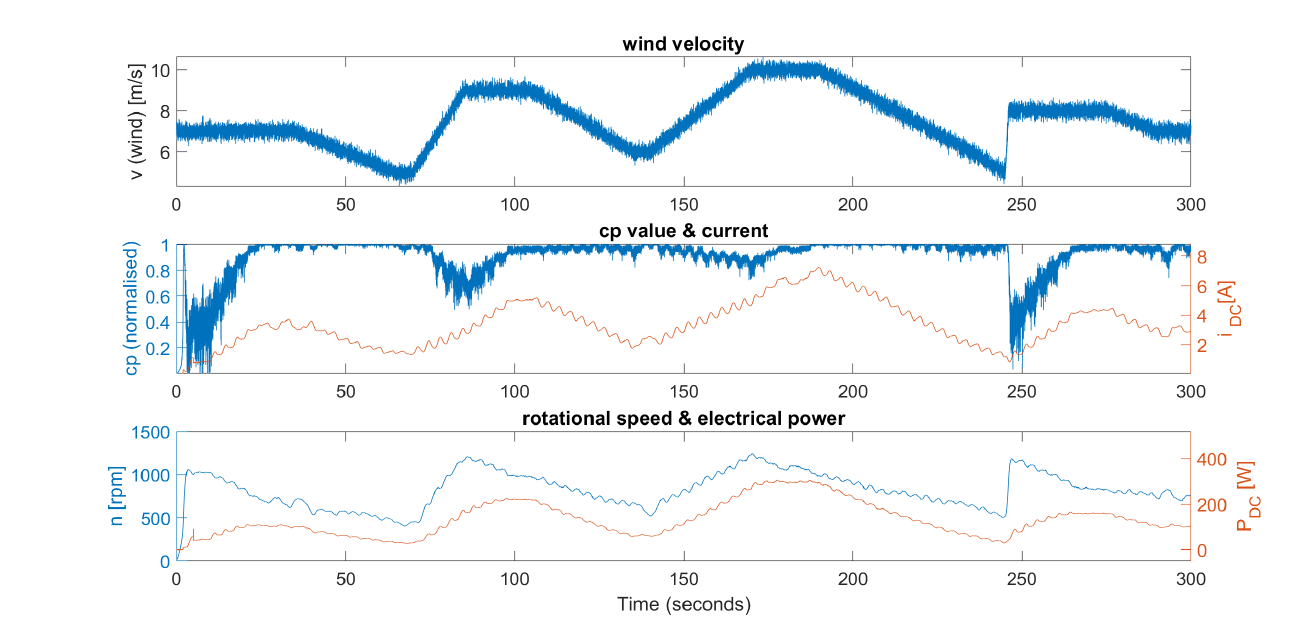
Figure 6. Simulation results with white noise added to the wind regimen to cover possible measurement errors.